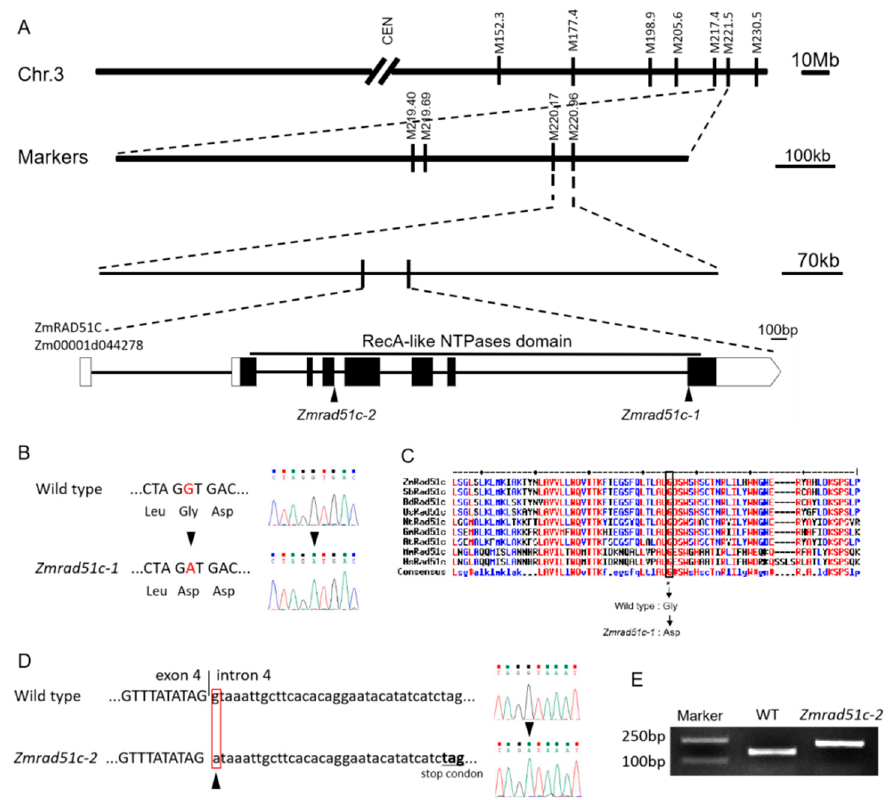
Figure 2. Map-based cloning of ZmRAD51C . ( A ) The procedure of map-based cloning of ZmRAD51C . CEN, centromere; M, markers. The mutation locus was mapped to a 787 kb region on the long arm